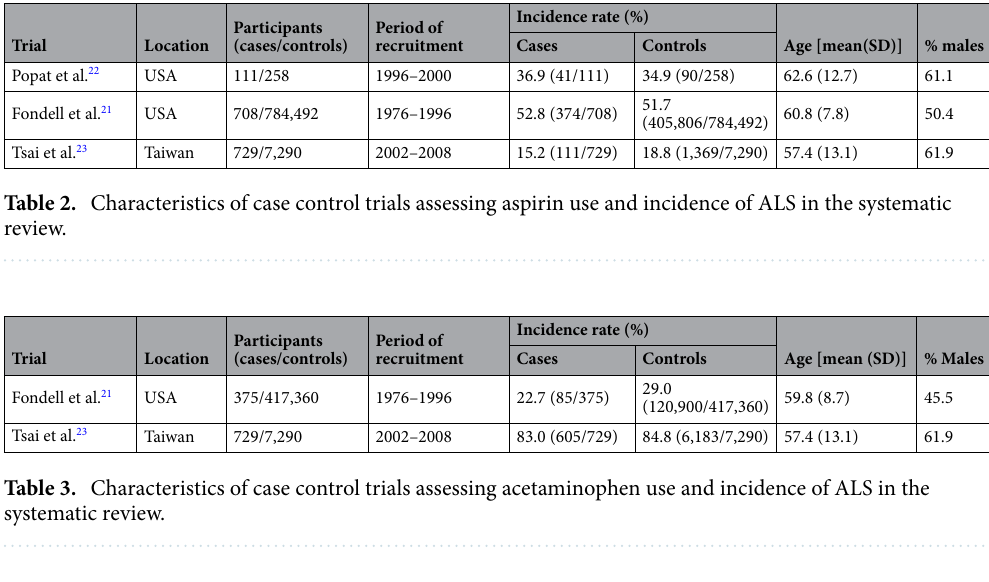
Table 3. Characteristics of case control trials assessing acetaminophen use and incidence of ALS in the systematic review.